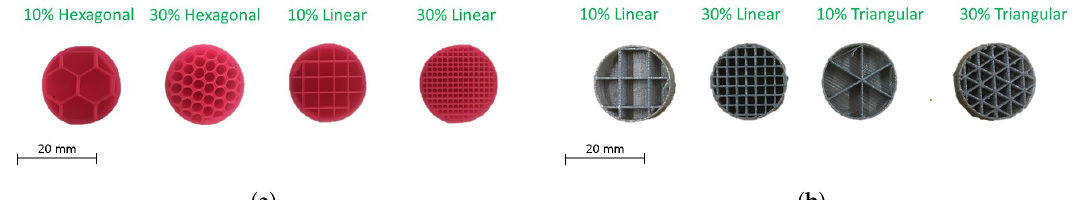
Figure 1. Cross-section of 3D printed specimens manufactured with: ( a ) Makerbot Replicator 2X; ( b ) Ultimaker 3